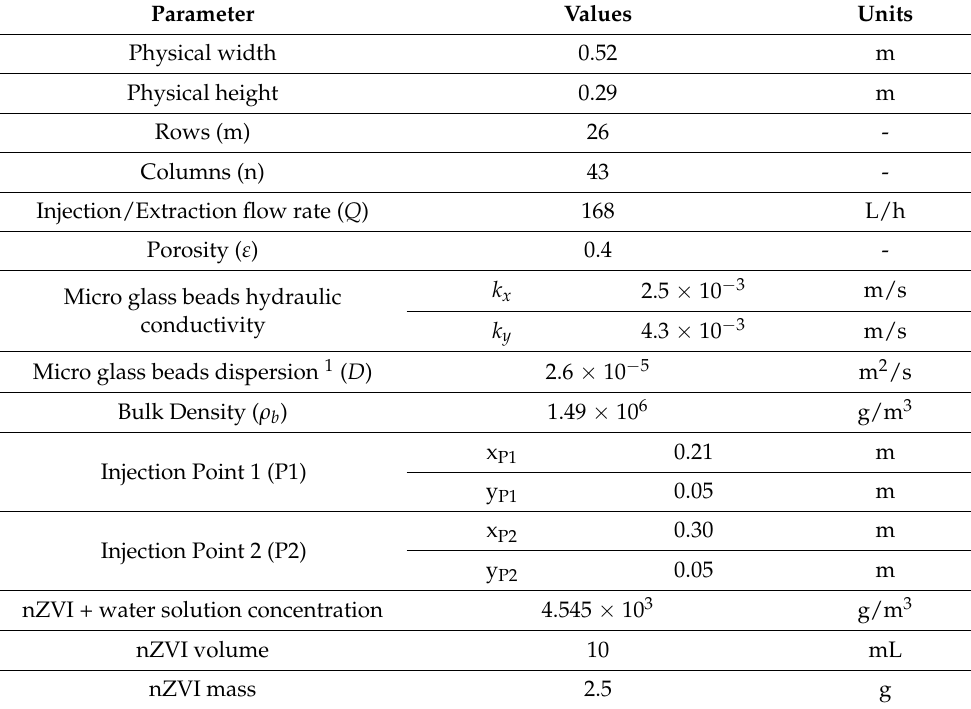
Table 5. Model Input